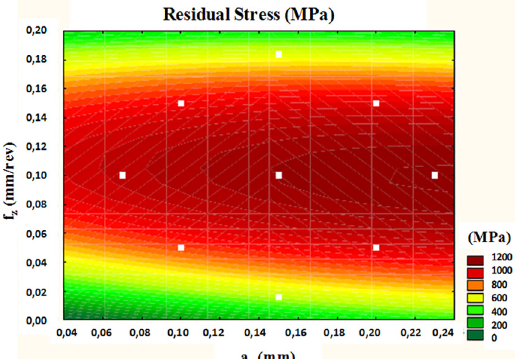
x f ) for the residual stress adopting p z